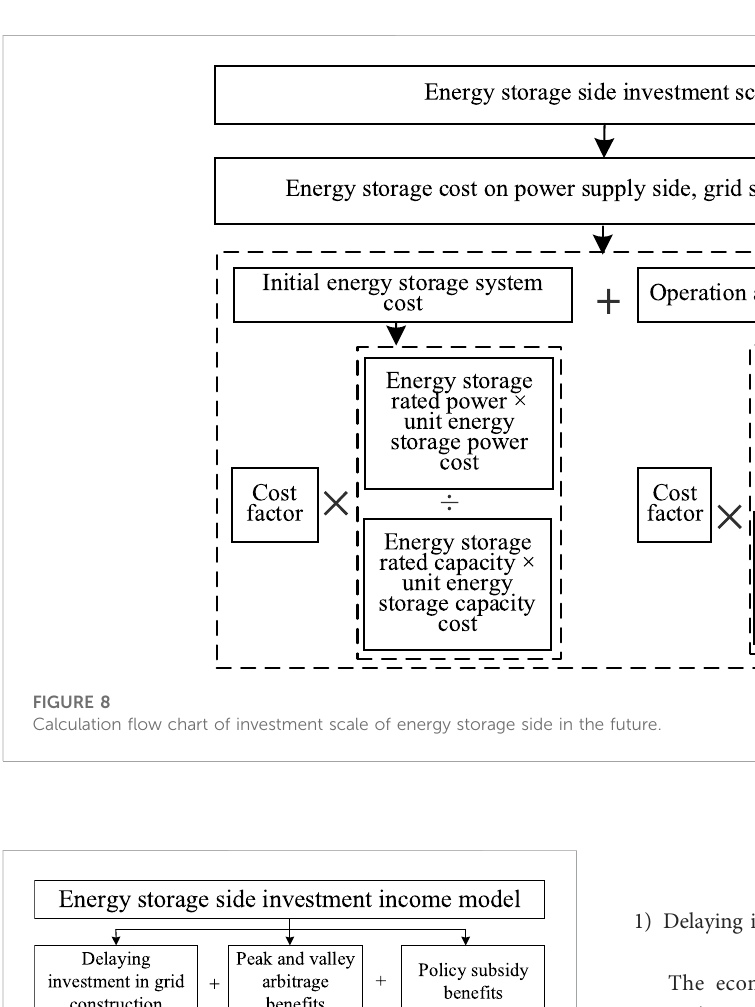
FIGURE 9 Flow chart of future annual investment income calculation of energy storage